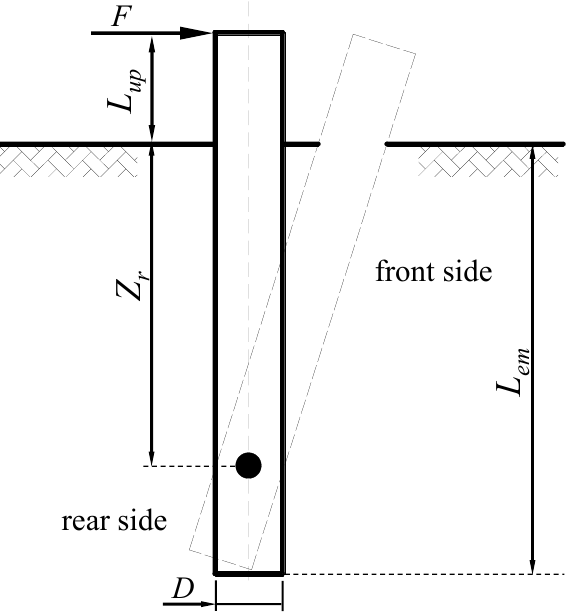
Figure 1. Sketch of a rigid monopile under lateral load.